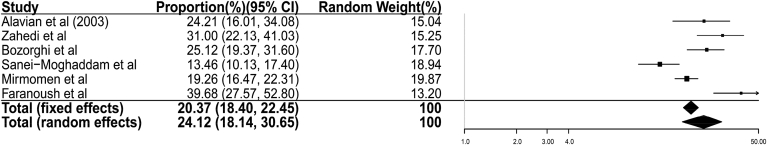
Overall rate of HCV infection in thalassemic patients in Iran (2003–2006). Pooled estimate of positive HCV serostatus in Iran was 20.37% (95% CI 18.40–22.45%) in the fixed effect model and 24.12% (95% CI 18.14–30.65%) in the random effect one with the inverse variance method.